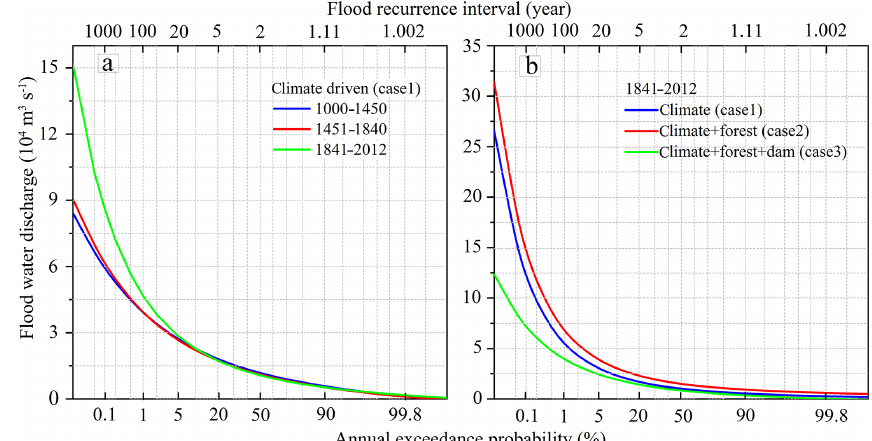
Figure 10. Frequency curves of annual maximum daily discharge for the Yalu River under different scenarios: (a) design floods estimated by three periods with different climatic characteristics, and the different effects of human activities in three periods were eliminated; (b) design floods estimated by dataset during 1841–2012 by setting three scenarios (climate, climate + forest cover, and climate + forest cover + dam).